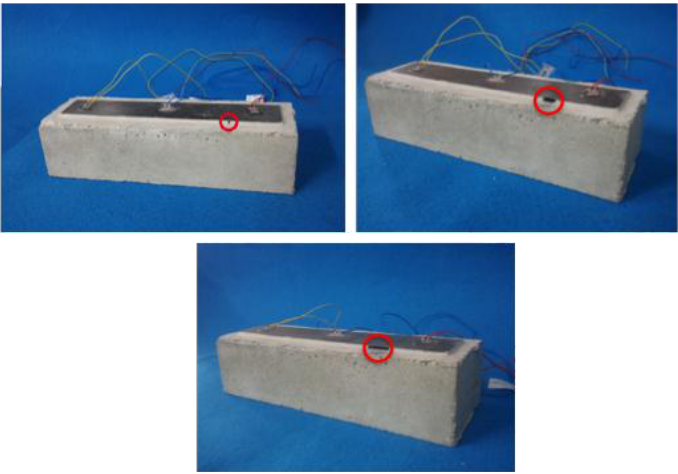
Figure 11. Damage scenario for an FRP-strengthened concrete specimen (I). Sensors 2016 , 16 , 639